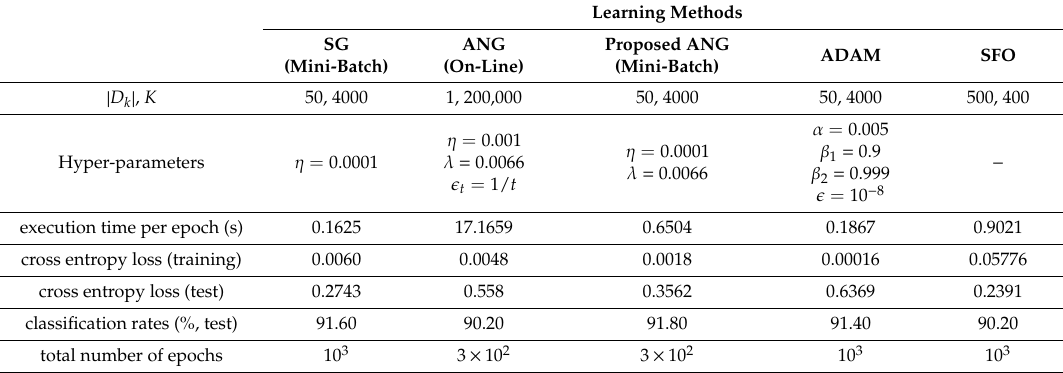
Table 2. Hyper parameters and training performances on spiral data classification.